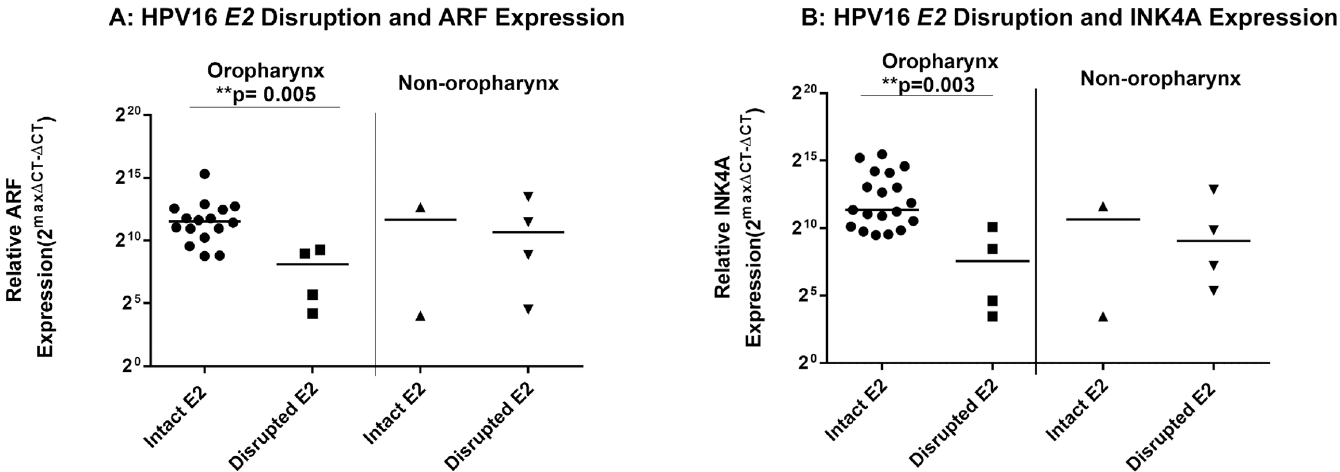
Fig 4. ARF and INK4A are overexpressed in OPSCCs with an intact E2. ARF (A) and INK4A (B) expression with HPV16 E2 gene disruption. Expression is defined as Y = 2max Δ CT- Δ CT where max Δ CT is the lower limit threshold of detection which equals 20 or 1. Δ CT is the experimental value minus the endogenous control (GAPDH). Statistical significance for difference in HPVE6 and E7 expression by site and between samples with an intact or disrupted HPV16 E2 gene was assessed by Mann-Whitney test.